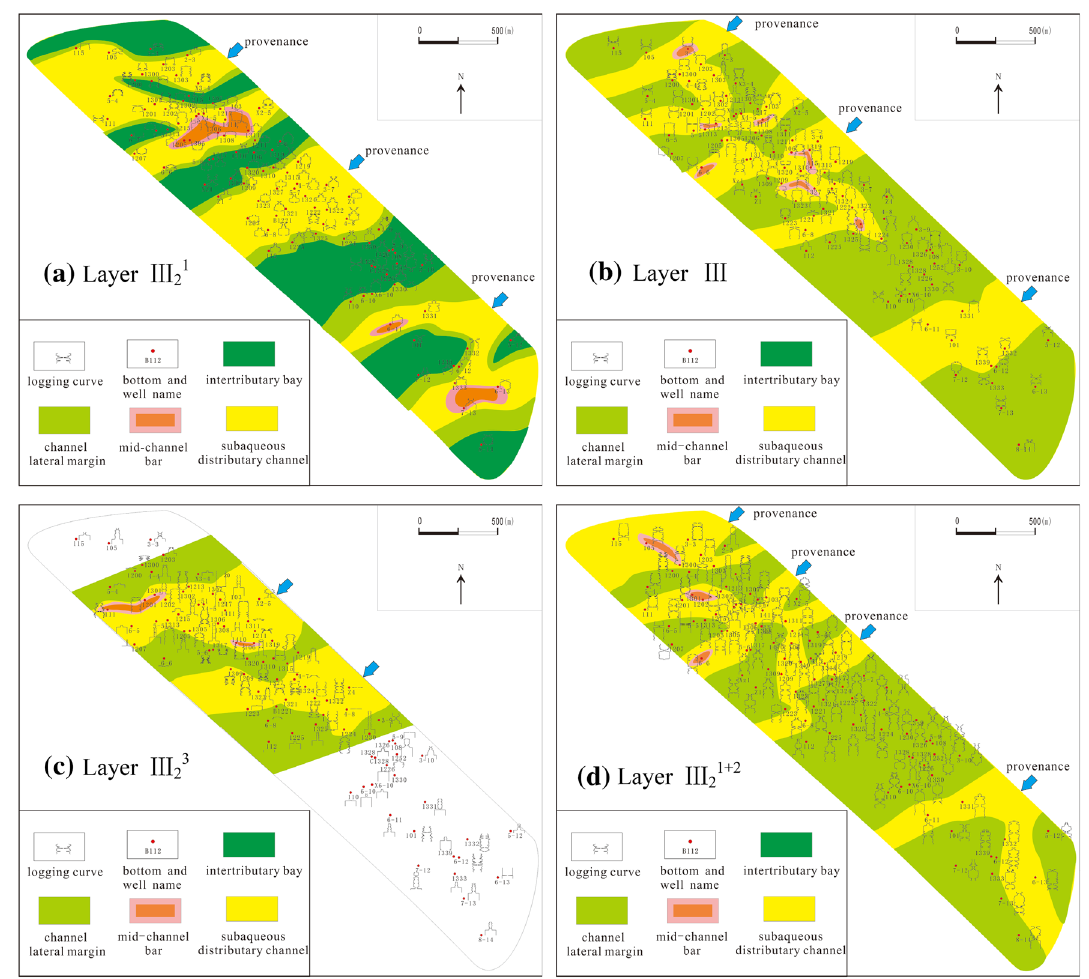
Fig. 11 Planar map of sedimentary petrofacies of III oil-bearing interval of Sanggonghe Formation in Baobei District, Baolang oilfield